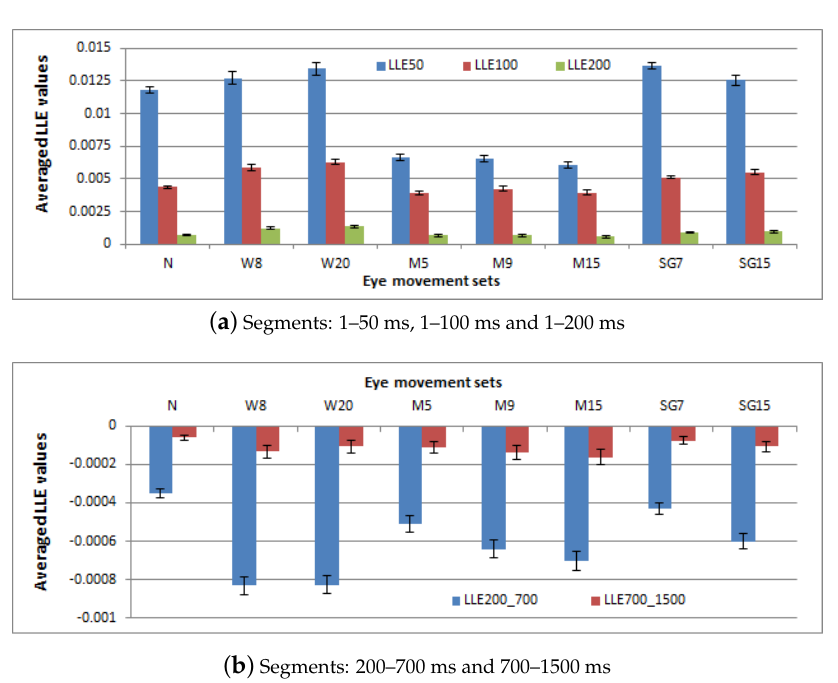
Figure 5. The Largest Lyapunov Exponent (LLE) calculated for different periods of the saccadic latency and for time series processed by different